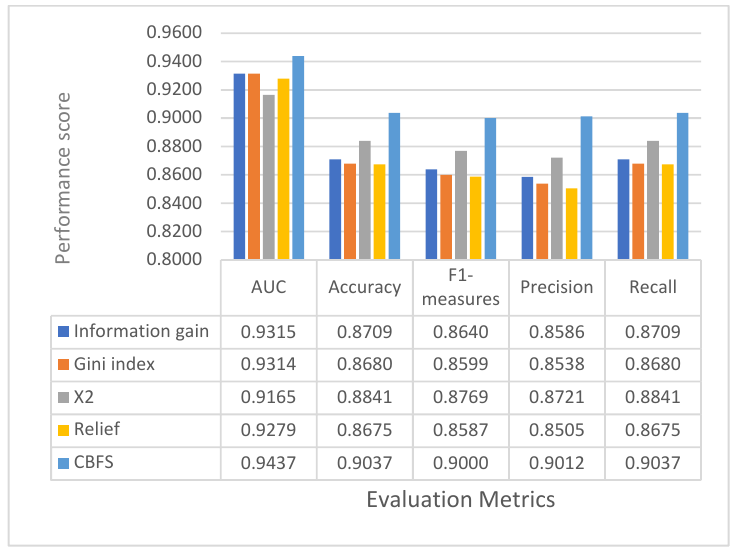
Figure 5. Performance of five feature selection methods on the breast ACPs using only 35 features.